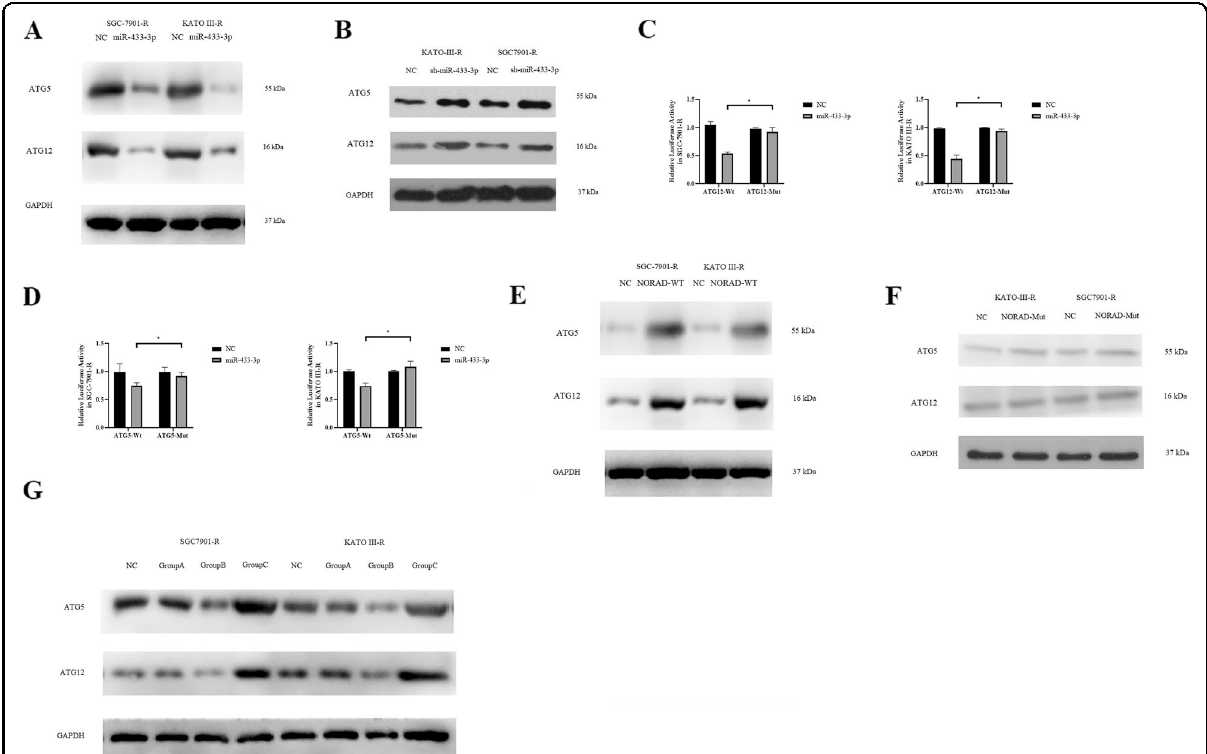
Fig. 7 miR-433-3p regulated autophagy by targeting ATG5 and ATG12. A Expression of ATG5 and ATG12 in miR-433-3p upregulated SGC-7901- R and KATO III-R cell line: ATG5(ATG5-ATG12 complex) 55 kDa, ATG12(free ATG12) 16 kDa, GAPDH 37 kDa. B Expression of ATG5 and ATG12 in miR- 433-3p knockdown SGC-7901-R and KATO III-R cell line: ATG5(ATG5-ATG12 complex) 55 kDa, ATG12(free ATG12) 16 kDa, ATG 78 kDa, GAPDH 37 kDa. C Dual-luciferase reporter gene assay for miR-433-3p and ATG12 in SGC-7901-R ( t = 8.789, P < 0.000) and KATO III-R ( t = 15.29, P < 0.000). D Dual- luciferase reporter gene assay for miR-433-3p and ATG5 in SGC-7901-R ( t = 2.260, P = 0.105) and KATO III-R ( t = 7.296, P = 0.002). E Expression of ATG5 and ATG12 in NORAD-Wt(containing the binding site for miR-433-3p) upregulated SGC-7901-R and KATO III-R cell line: ATG5(ATG5-ATG12 complex) 55 kDa, ATG12(free ATG12) 16 kDa, ATG 78 kDa, GAPDH 37 kDa. F Expression of ATG5 and ATG12 in NORAD-Mut (containing the binding site for miR-433-3p) upregulated SGC-7901-R and KATO III-R cell line: ATG5(ATG5-ATG12 complex) 55 kDa, ATG12(free ATG12) 16 kDa, ATG 78 kDa, GAPDH 37 kDa. G miR-433-3p knockdown could reverse the downregulation of ATG12 and ATG5 that was induced by NORAD knockdown. Group A: NORAD knockdown + miR-433-3p knockdown; Group B: NORAD knockdown; Group C: miR-433-3p